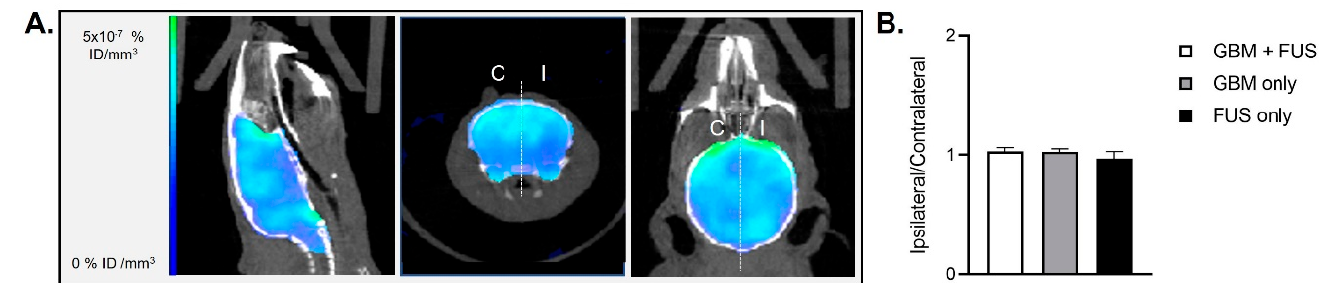
Figure 4. BBB permeabilization and [18F]FDG PET/CT imaging on healthy and tumor-bearing animals. ( A ) Brain representative images of [18F]FDG-mediated PET/CT two days after hemispheric trajectory focused ultrasound in an animal of group “GBM + FUS” (tumor-bearing animals undergoing FUS-mediated BBB permeabilization). The white dotted line represents the separation between ipsilateral (I) and contralateral (C) brain hemispheres that was used for the quantifications; ( B ) Quantification of [18F]FDG activity in animals of group “GBM + FUS” (tumor-bearing animals undergoing FUS-mediated BBB permeabilization, n = 5), group “GBM only” (tumor-bearing animals without FUS-mediated BBB permeabilization, n = 5) and group “FUS only“ (healthy animals undergoing hemispheric FUS-mediated BBB permeabilization, n = 4). Results are expressed as ipsilateral/contralateral ratio (mean ± SEM).